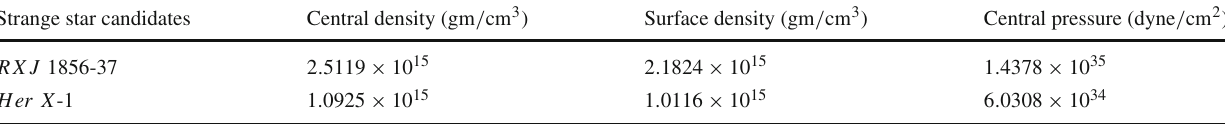
Table 6 Energy densities and pressure for different strange star candidates for the above parameter values of Table 1 Strange star candidates Central density (gm / cm 3 ) Surface density (gm / cm 3 ) Central pressure (dyne / cm 2